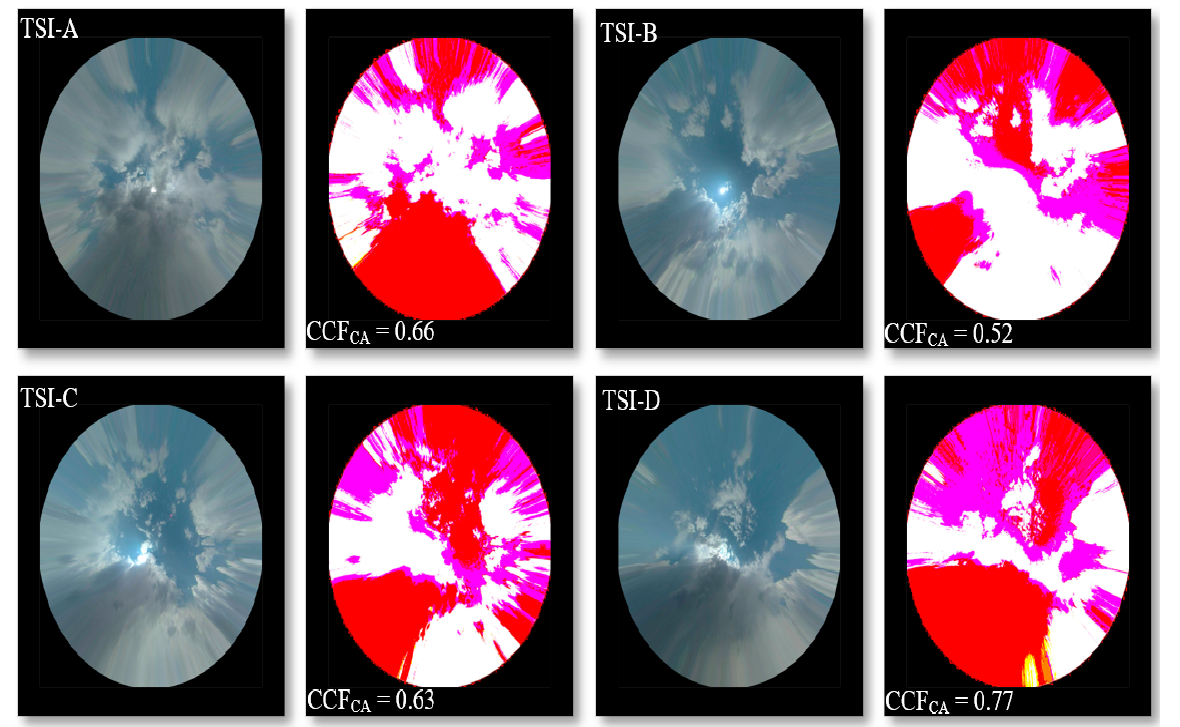
Figure 5. Normal TSI and the calibrated images using the developed CA algorithm (15 June 2022 11:30).